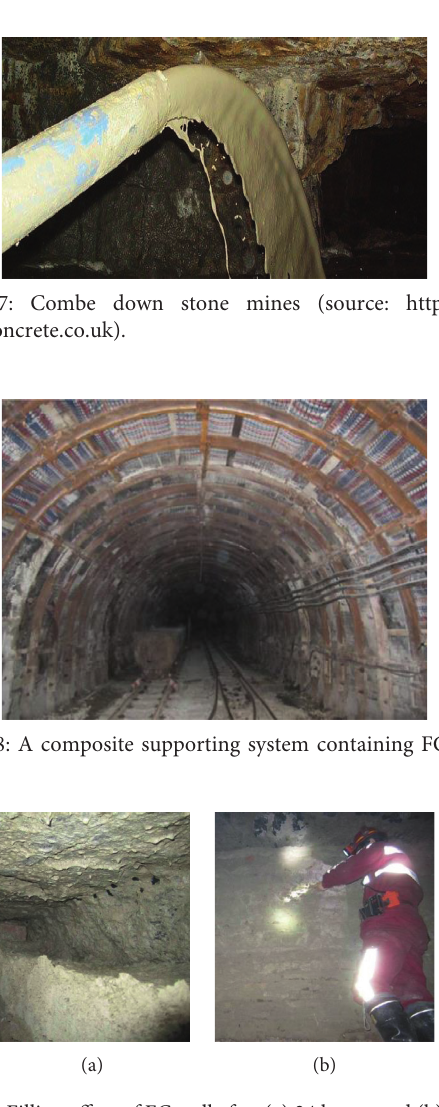
Figure 9: Filling effect of FC wall after (a) 24 hours and (b) 28 days [245].